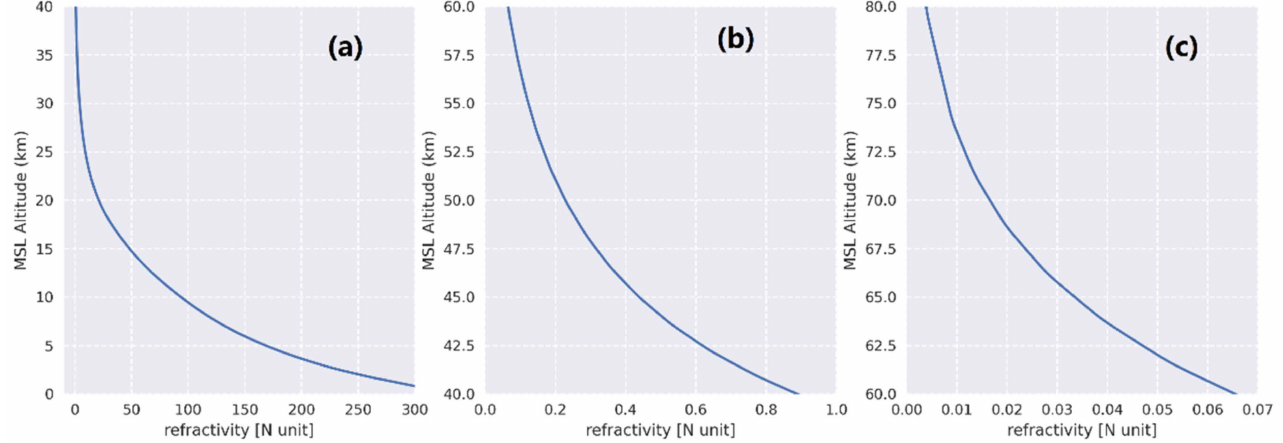
Figure A5. Mean refractivity in 0–40 km, 40–60 km, and 60–80 km, and their order of magnitude are